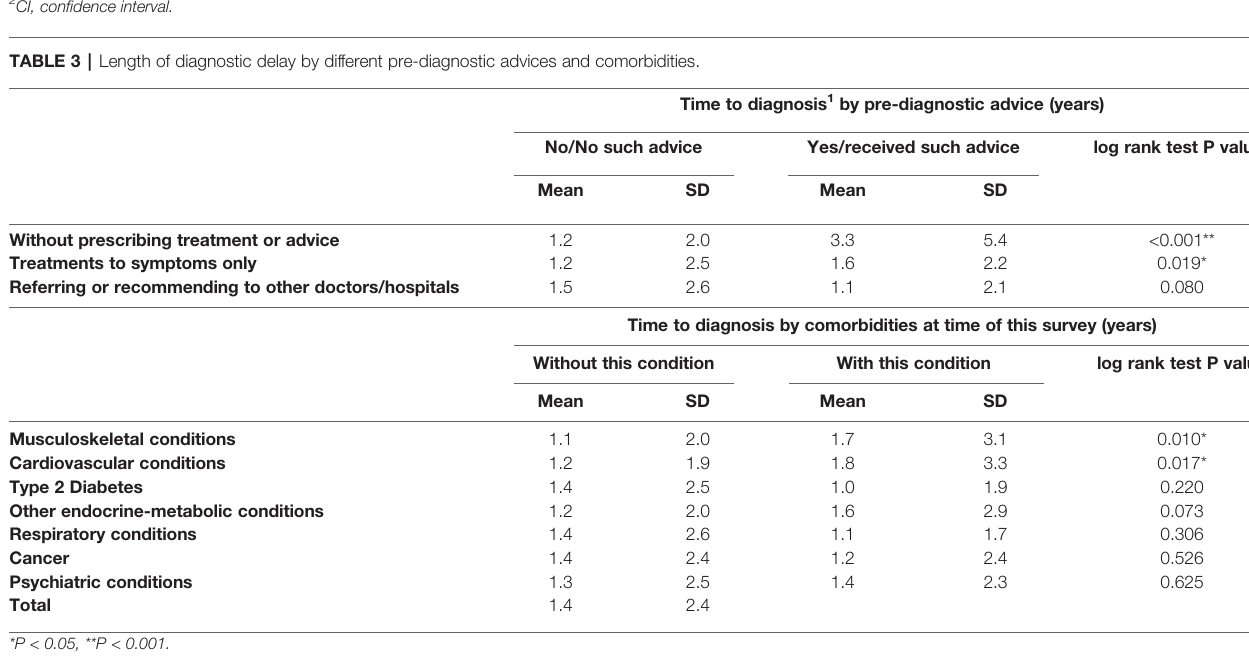
( Table 4 ). Internet search (9.2%) and patient groups (5.4%) played less signi fi cant roles in helping patients to fi nd such hospitals.